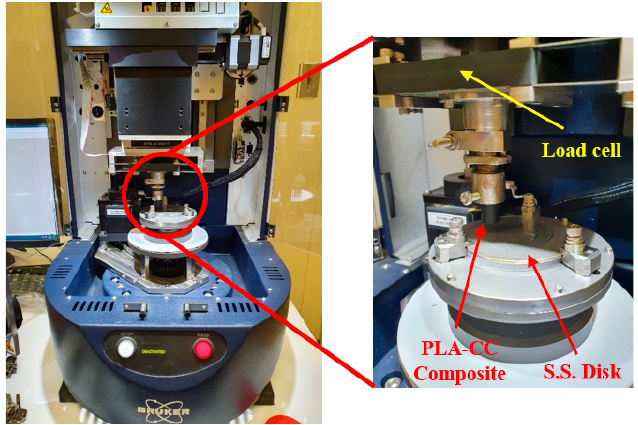
Figure 2. The tribometer for tribological test.